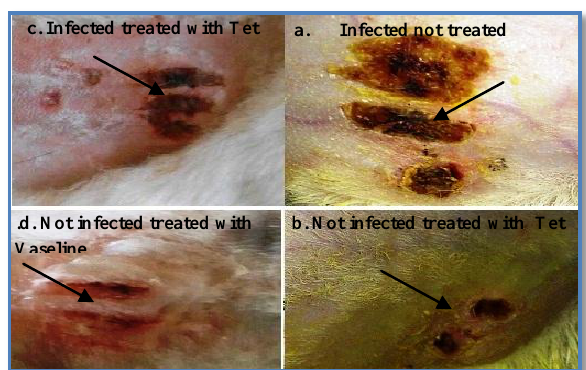
a. Infected treated with